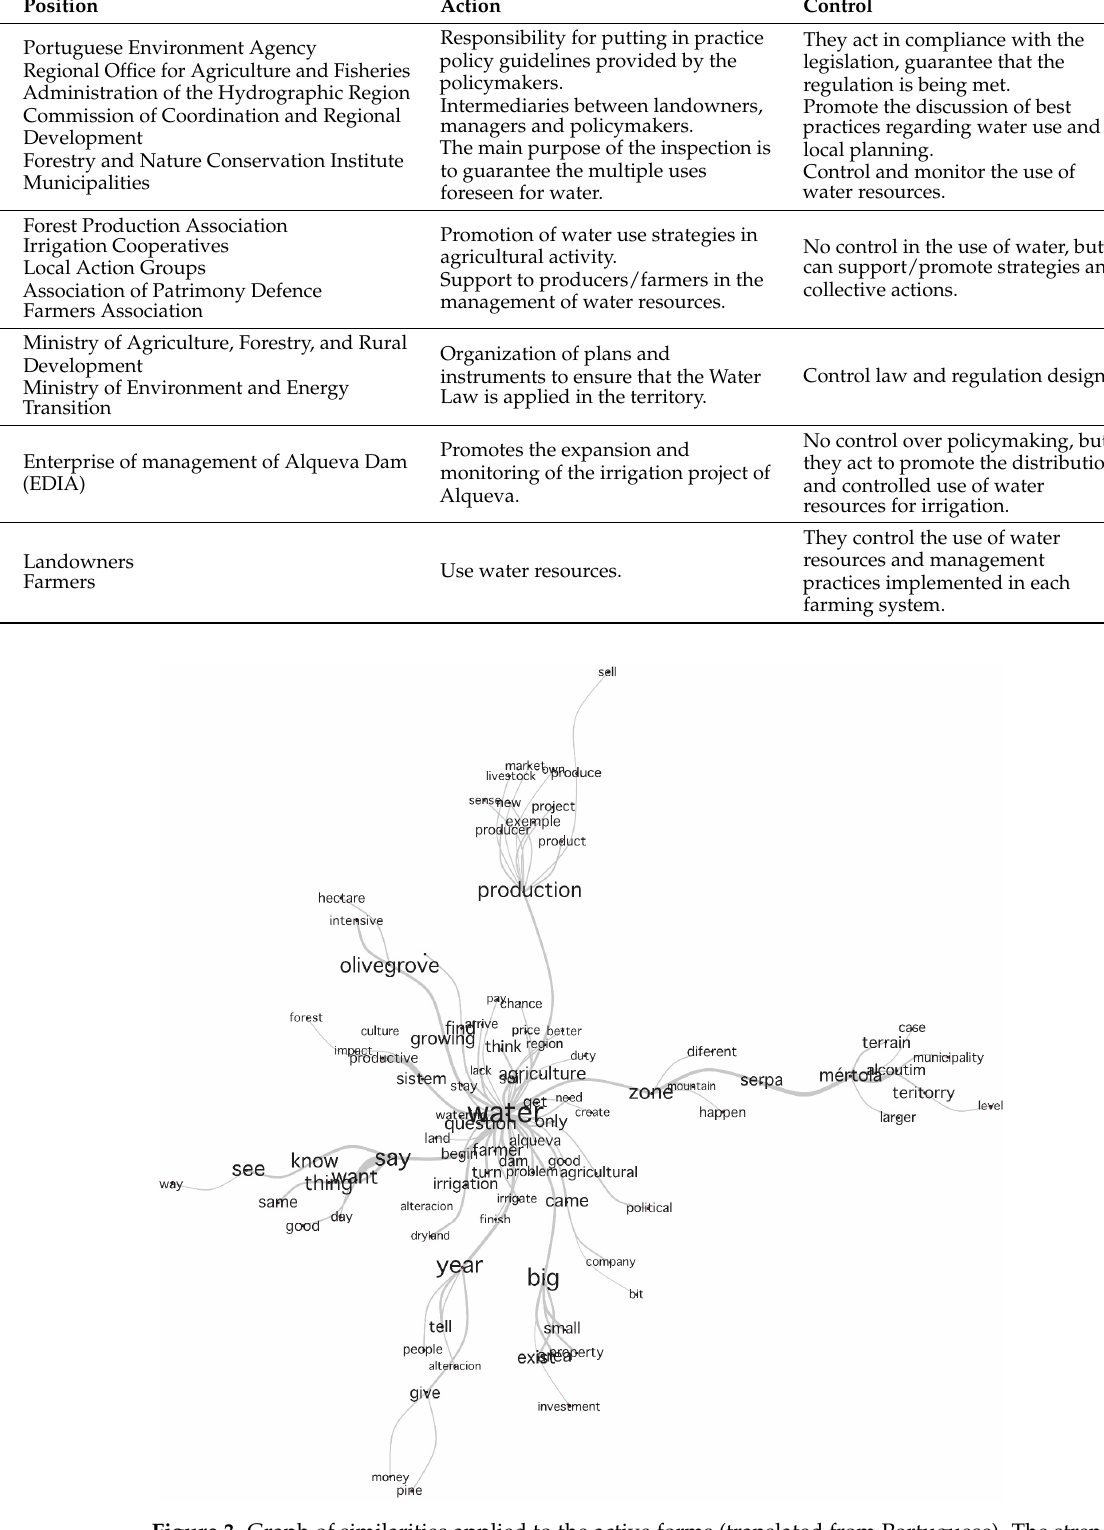
Figure 3. Graph of similarities applied to the active forms (translated from Portuguese). The strength of the relationship between the forms is represented by the thickness of the lines, while the font size of the forms indicates the frequency of occurrences of the forms. Source: research data analysed by IRAMUTEQ.